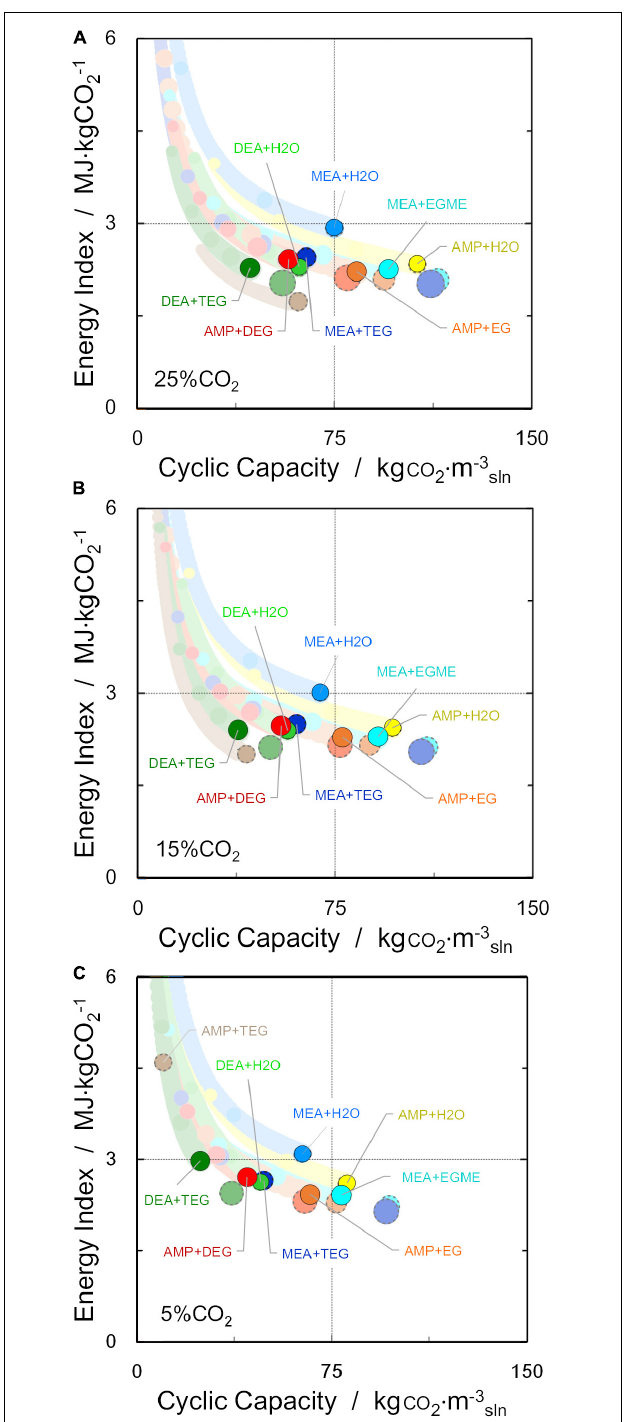
FIGURE 4 | Estimated evolution of solvent cyclic capacity and energy index of alternative aqueous amines (30 wt%) for (A) 25% CO 2 /75% N 2 , (B) 15% CO 2 /85% N 2 , and (C) 5% CO 2 /95% N 2 binary mixtures ( T rich = 313 K, P lean = 0.2 MPa). Highlighted spheres correspond to a regeneration temperature of 403 K, while dashed spheres represent the maximum cyclic capacity achieved with each material (at T lean > 403 K). Colors at the background indicate regeneration at lower regeneration